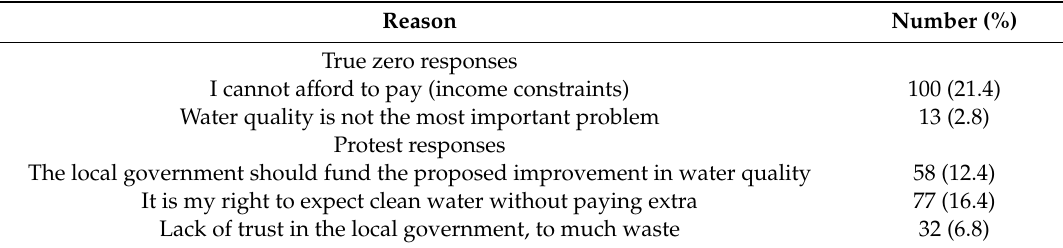
Table 2. Reasons for a “No” WTP response.